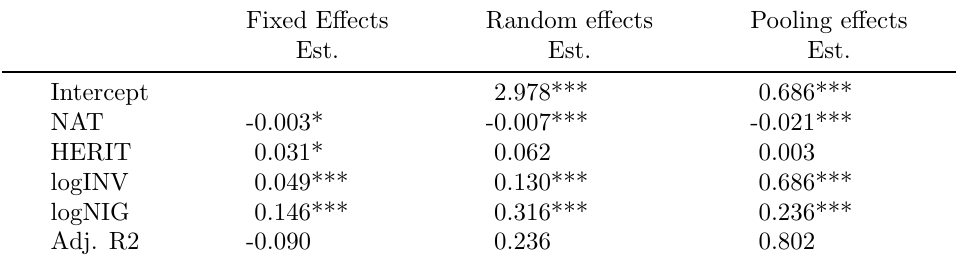
Table A.1: Panel estimations